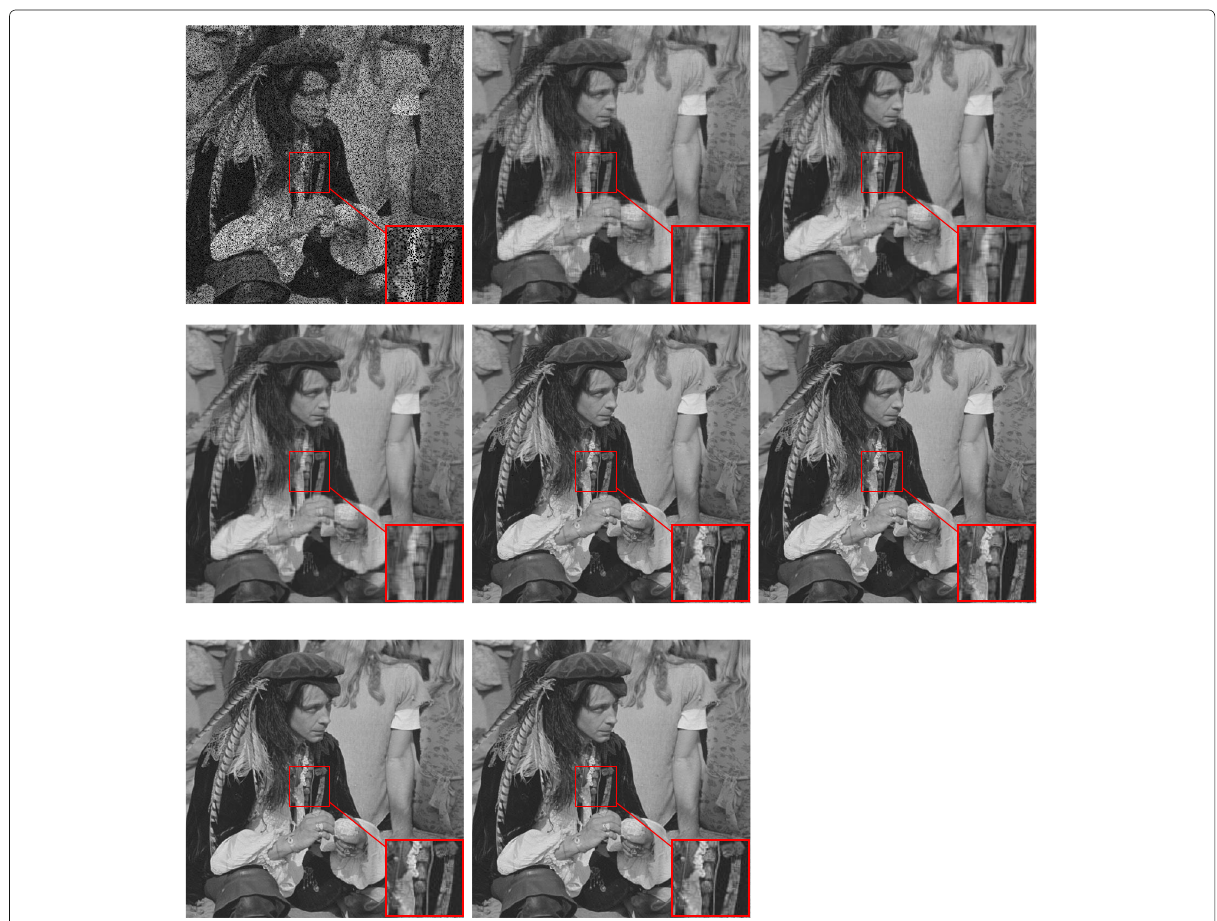
Fig. 2 Results obtained for image “man” using the different methods. From left to right, the order of the images is as follows: simulated image with missing data, recovered image using FPC algorithm, recovered image using ALM algorithm, recovered image using IALM algorithm, recovered image using PPG algorithm, recovered image using PG algorithm, recovered image using SVT with power method, and finally the recovered image using our proposed